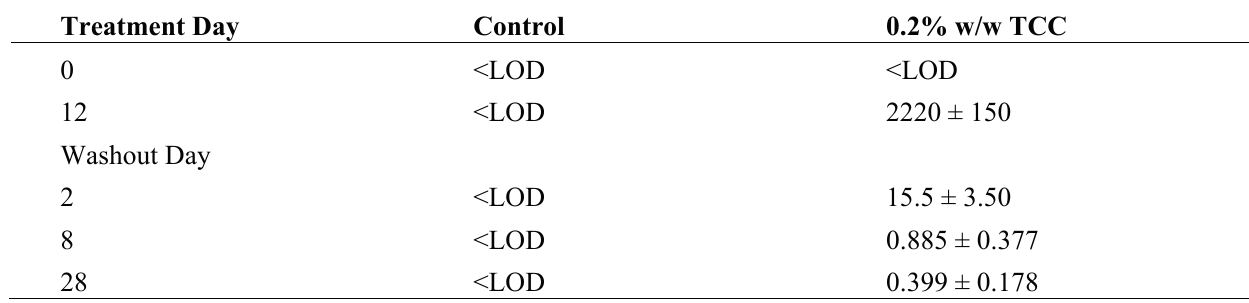
Table 2. Fecal TCC concentration during treatment and washout